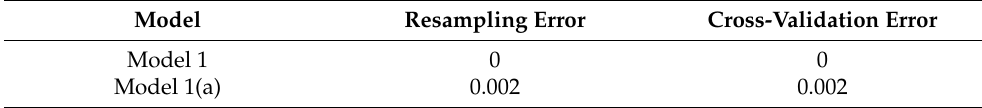
Table 1. Decision model resampling error and cross-validation error values.